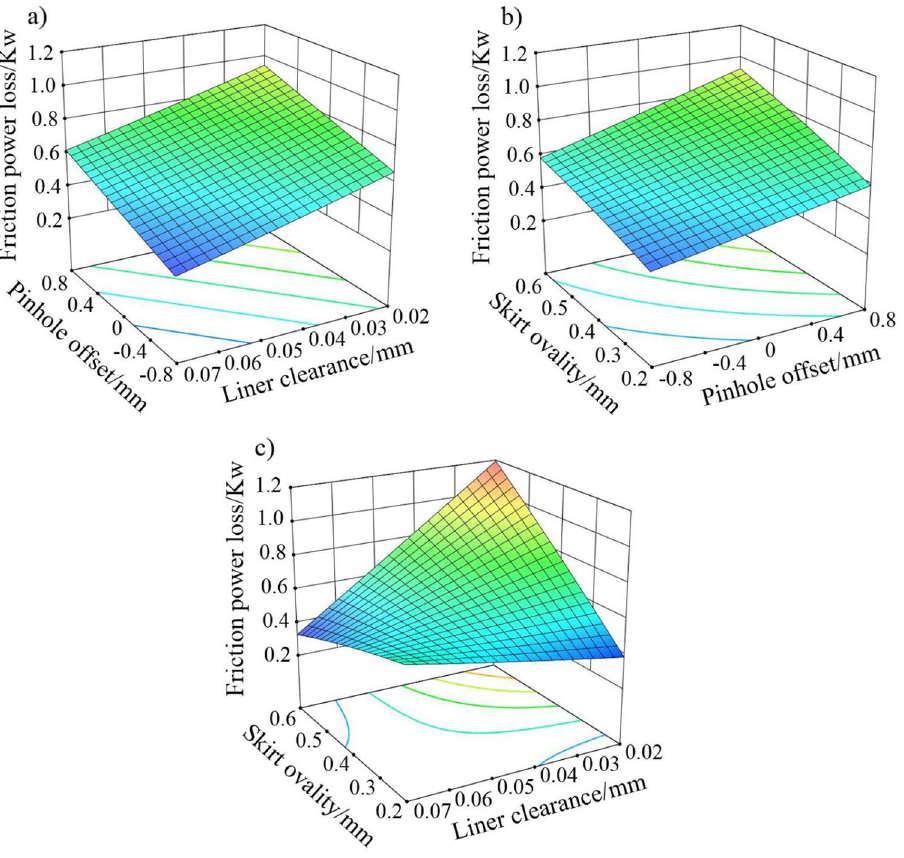
Figure 13. Response surfaces of effects on friction power loss of ( a ) pinhole offset and liner clearance, ( b ) pinhole offset and skirt ovality, and ( c ) liner clearance and skirt